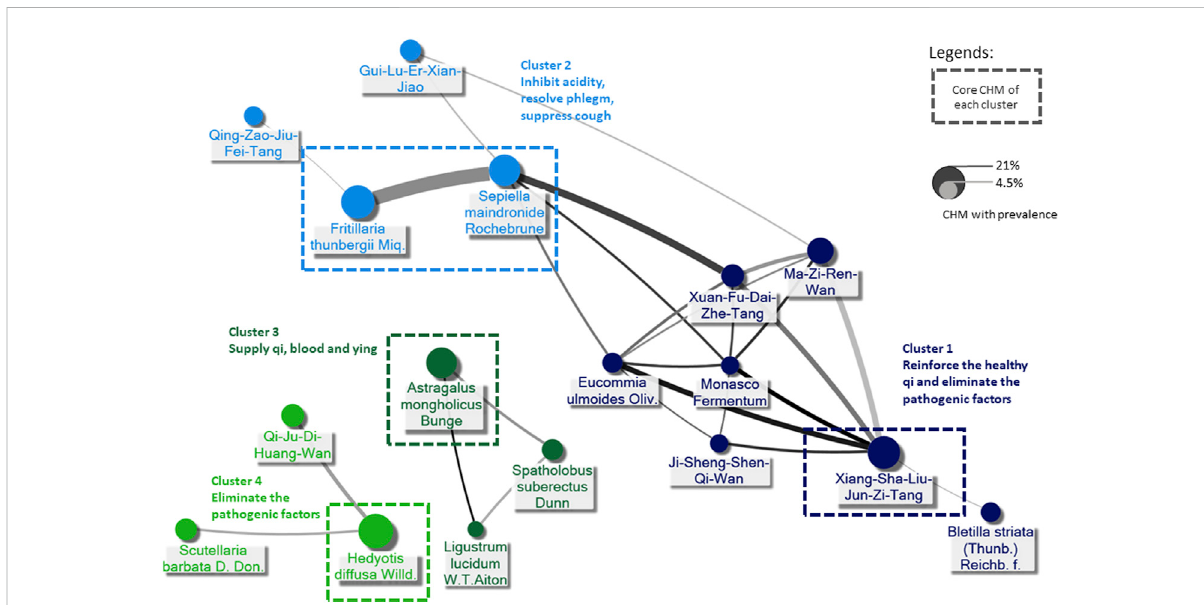
FIGURE 3 Demonstration of CHM prescriptions used for stage IV esophageal cancer (EC) by Chinese herbal medicine network (CMN). The core CHM of eachclustercouldbeproposed bysocial network analysis(SNA).CHMindicationswereadoptedfromtheTaiwanHerbalPharmacopeia (4thedition, the Ministry of Health and Welfare, Taiwan), CHM indications provided by the website of the Ministry of Health and Welfare in Taiwan (https://dep. mohw.gov.tw/docmap/lp-874-108.html), and the Pharmacopeia of the People ’ s Republic of China, 2015 edition.